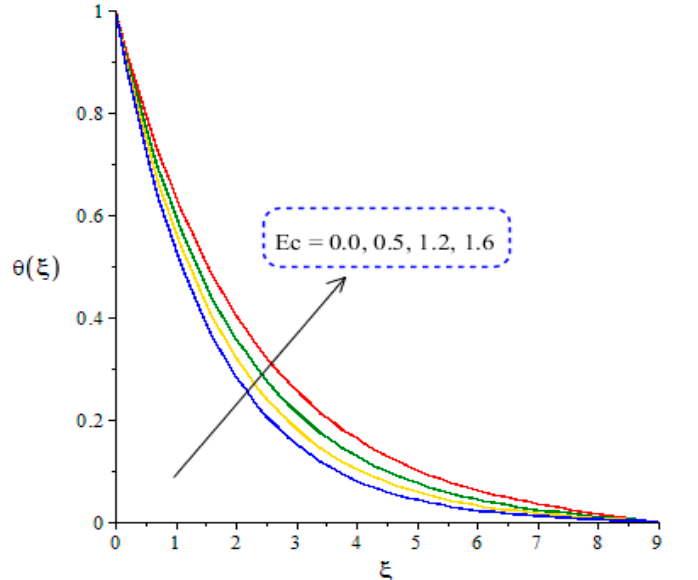
Figure 13. Variation role of θ ( ξ ) versus Ec when m = 0.3, We = 3, Ω = 2.0, M 2 = 0.3, β e = 0.5, Figure 13. Variation role of 𝜃(𝜉) versus 𝐸𝑐 when 𝑚 = 0.3,𝑊𝑒 = 3, Ω = 2.0, 𝑀 (cid:2870) = 0.3, 𝛽 (cid:3032) = 0.5, 𝛽 (cid:3036) = 0.7,𝜖 = 0.01, 𝐹 (cid:3045) = 2.5,𝑃𝑟 = 204,𝜑 (cid:2870) = 0.0075, 𝜑 (cid:2869) = 0.002, 𝜑 (cid:2871) = 0.005. β i = 0.7, (cid:101) = 0.01, F r = 2.5, Pr = 204, ϕ 2 = 0.0075, ϕ 1 = 0.002, ϕ 3 = 0.005.